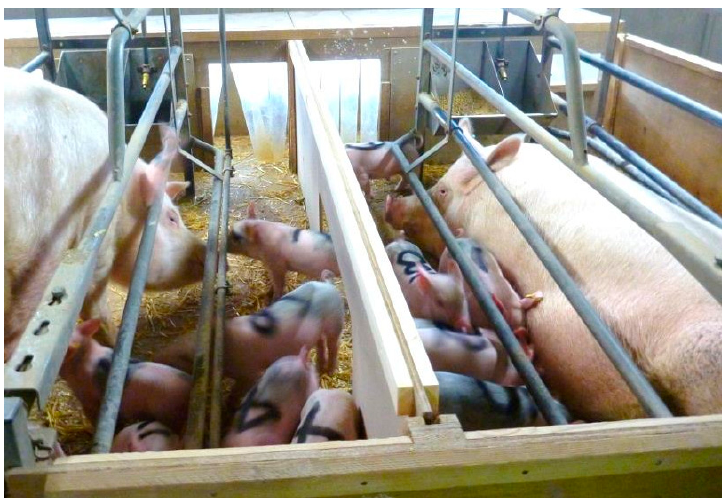
Figure 1. Photo taken just after the solid barrier was replaced by a wooden barrier that allowed the piglets to move freely between the two pens. Photo credit: M. Farish.